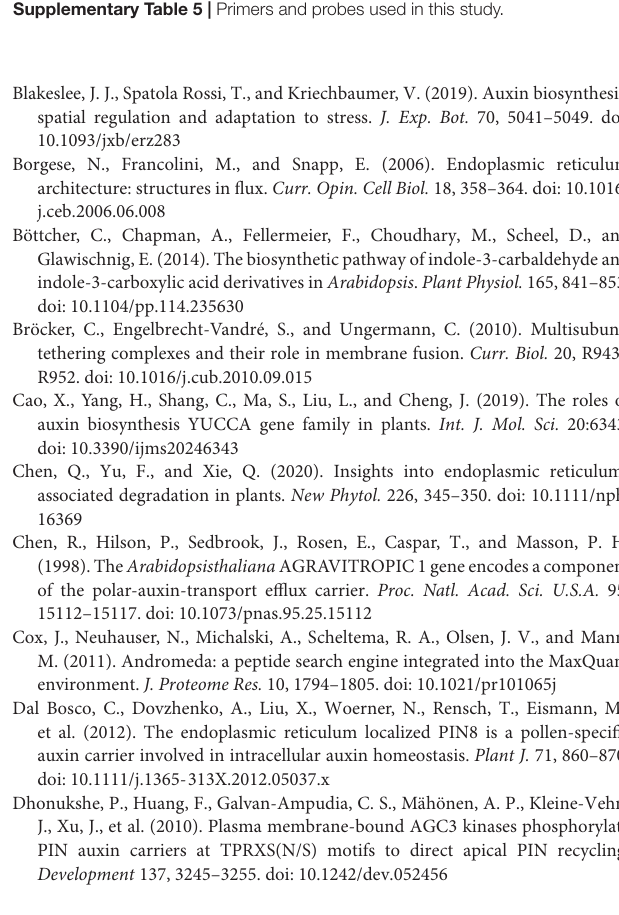
Supplementary Table 2 | Gene Ontology (GO) enrichment analysis of differently accumulated proteins (DAPs). Supplementary Table 3 | Vesicle trafficking-related DAPs. Supplementary Table 4 | Auxin-related DAPs. Supplementary Table 5 | Primers and probes used in this